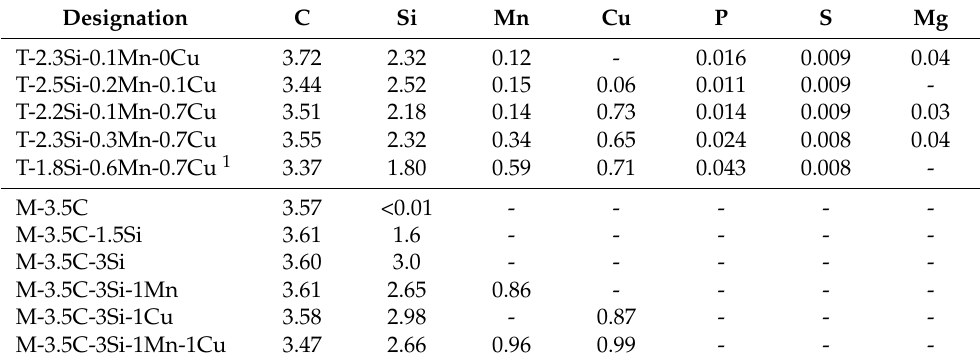
Table 1. Elemental composition (Fe-based) in wt% of the commercially available cast irons (T) and of the model alloys (M)